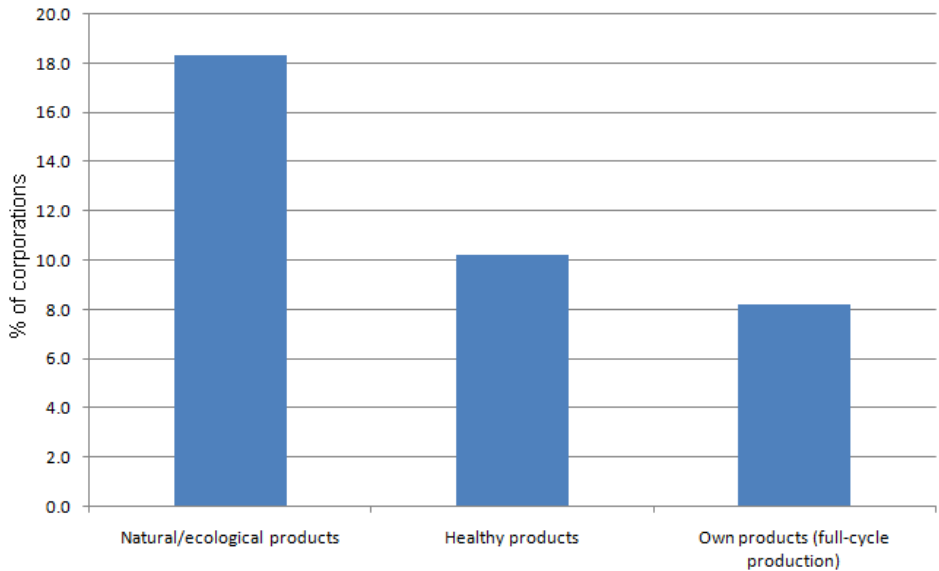
Figure 4. Supplementary themes of the corporate web positioning of the considered Russian agricultural corporations.